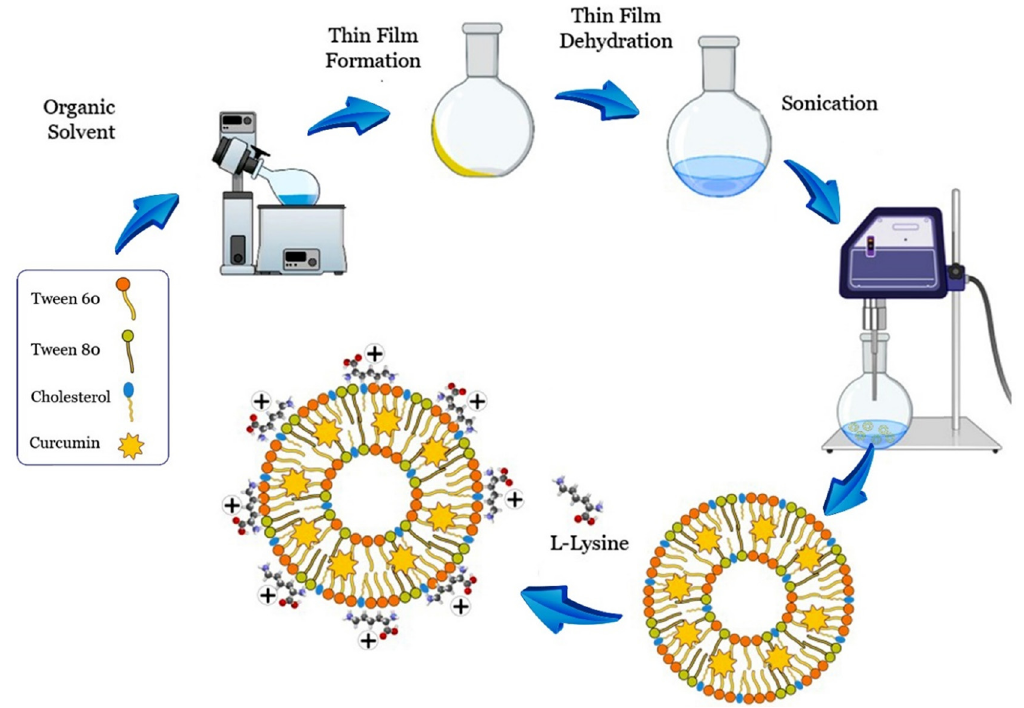
Figure 2: Schematic representation of the synthesis method and preparation of lysine - mediated niosomal NPs loaded with